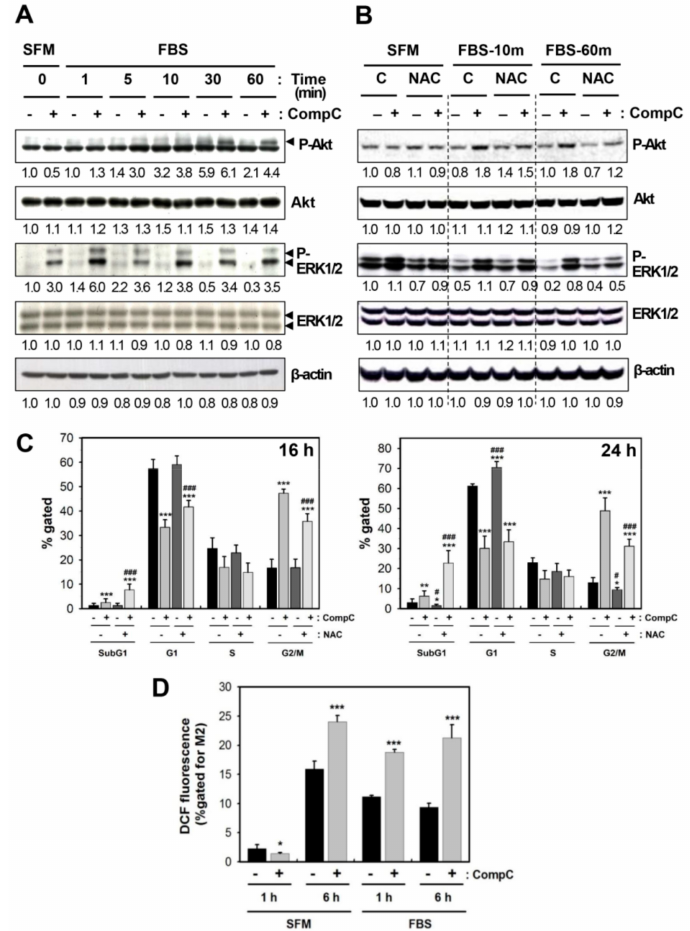
Figure 3. CompC increased the phosphorylations of Akt and ERK1 / 2 via reactive oxygen species (ROS) production in B16-F1 cells. ( A ) B16-F1 cells were stimulated with 10% FBS for the indicated times in the presence of vehicle or 10 µ M CompC. Cell lysates were analyzed by western blot analysis using antibodies against total and phosphorylated Akt (P-Akt) and ERK1 / 2 (P-ERK1 / 2). ( B ) Serum-starved cells were pretreated with vehicle alone, 5 mM N-acetyl cysteine (NAC) and / or 10 µ M CompC for 1 h. Cells were stimulated with FBS for 10 and 60 min. Cell lysates were analyzed by western blot analysis. ( C ) B16-F1 cells were treated with vehicle or 10 µ M CompC in the absence or presence of 5 mM NAC for 16 and 24 h, and the cell cycle was analyzed by flow cytometry. The % gated fractions of sub-G1, G1, S, and G2 / M at 16 and 24 h are plotted as the mean ± SD. ( D ) Serum-starved cells were treated with medium containing serum free medium (SFM) or FBS in the presence of vehicle or 10 µ M CompC for 1 and 6 h. The level of ROS was measured by flow cytometry and % gated for M2 is plotted. * p < 0.05, ** p < 0.01, and *** p < 0.001, compared with vehicle-treated control cells. # p < 0.05, ### p < 0.001, compared with CompC alone-treated cells in the absence of